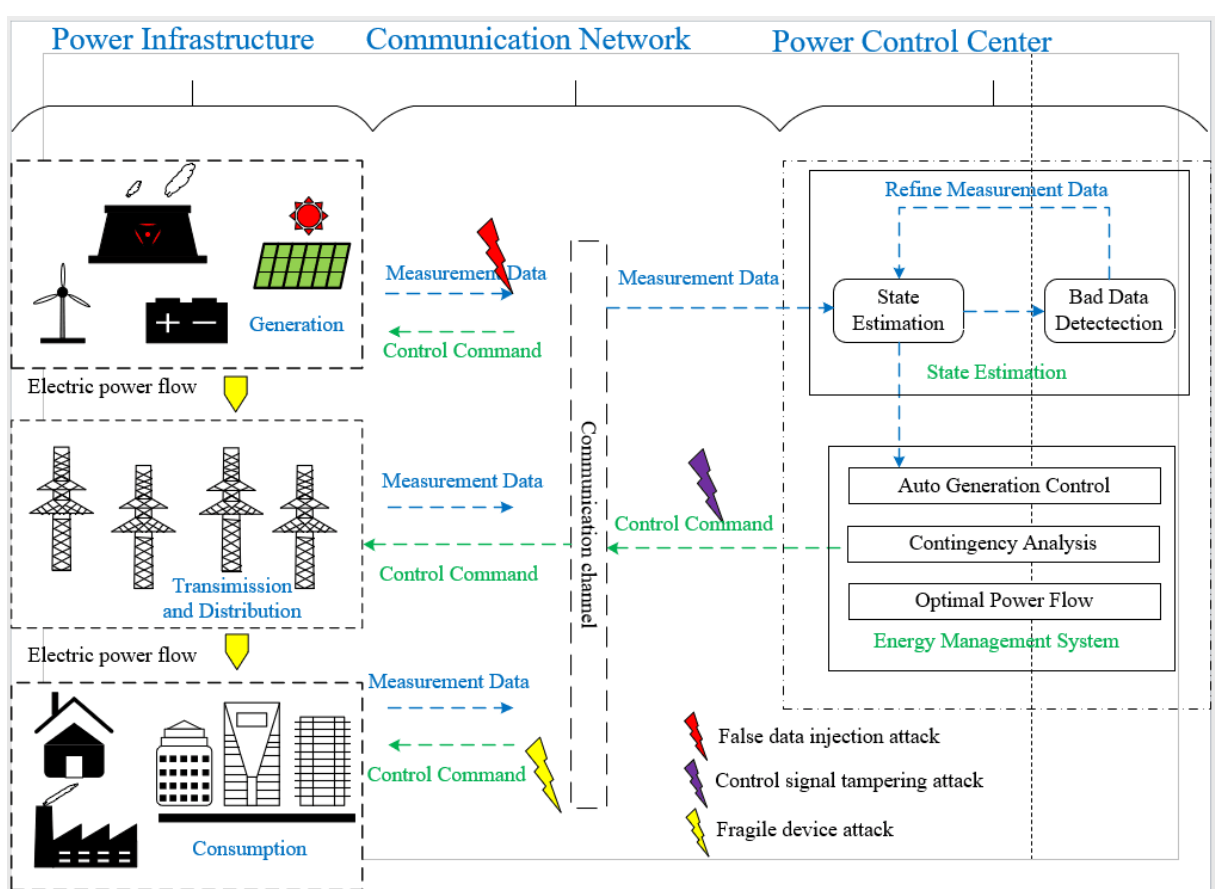
Figure 1. Network attack intrusion path.